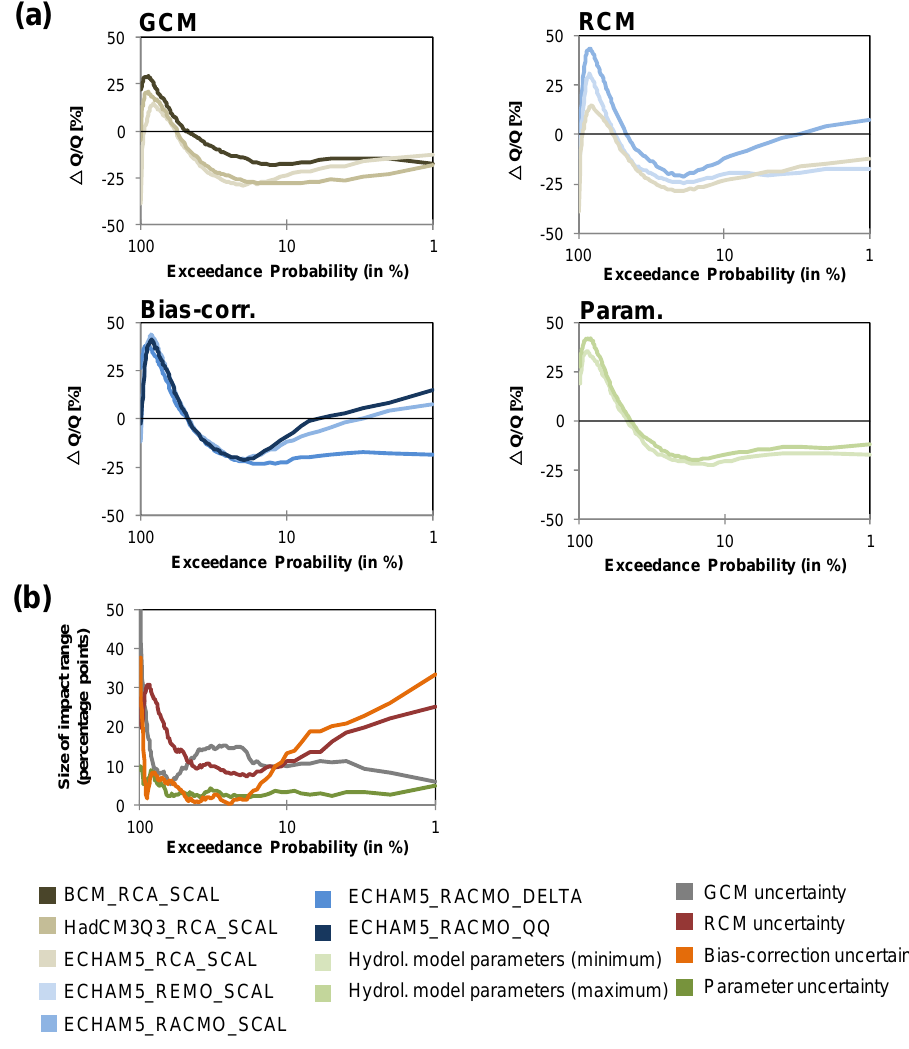
Fig. 9. (a) Uncertainty in flow exceedance probabilities resulting from GCM, RCM, bias-correction and hydrological model parameters. (b) Size of impact range originating from each uncertainty source. The differences (percentage points) between the minimum and maximum values are plotted.